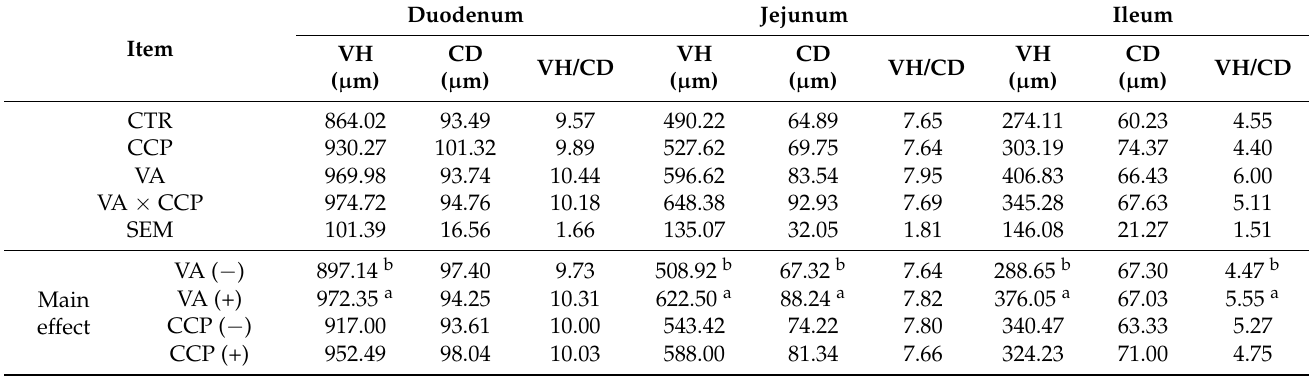
Table 9. Effect of vitamin A on the intestinal morphology of broiler chickens co-infected with CCP on day